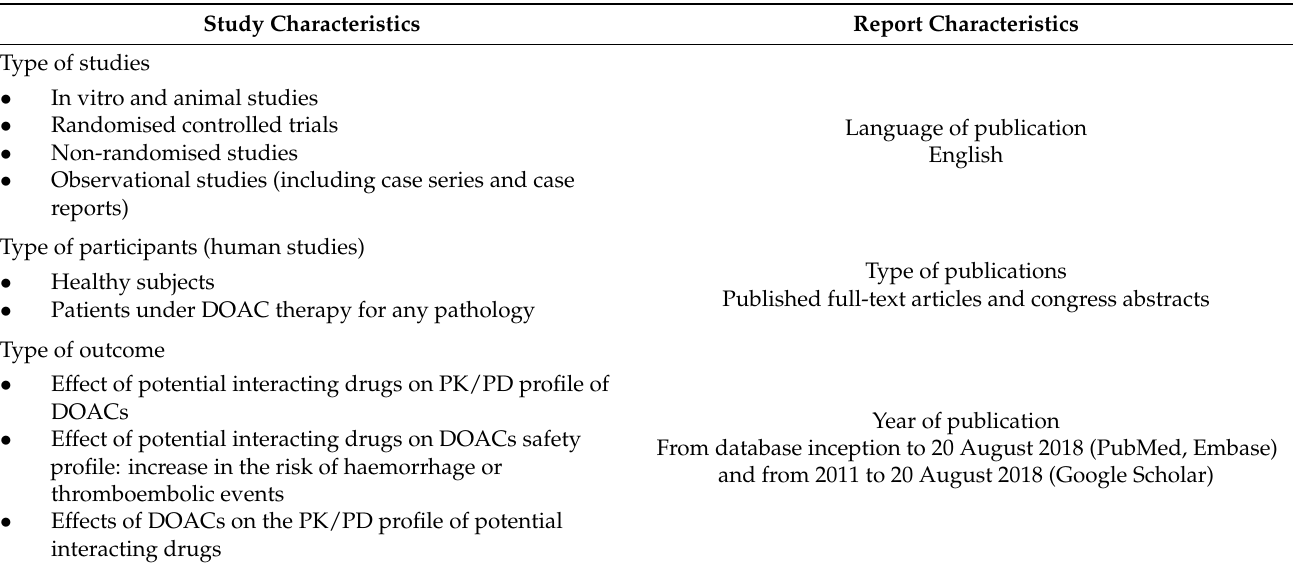
Table 1. Eligibility criteria